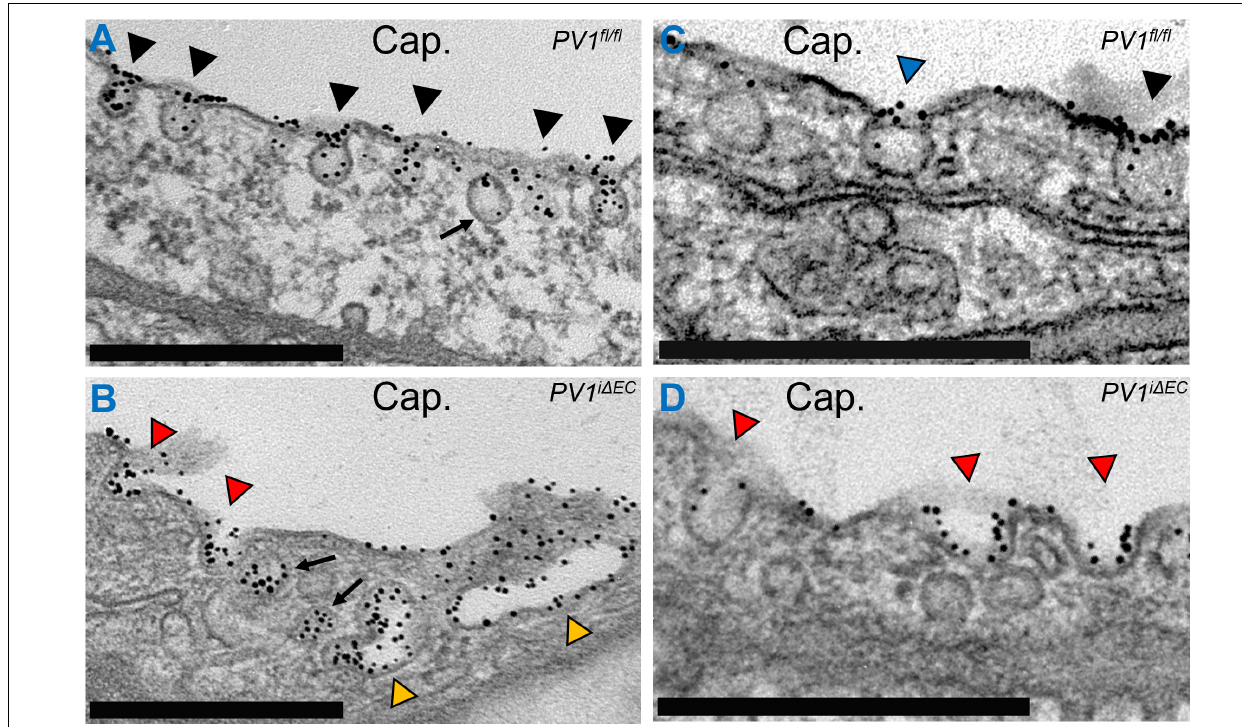
FIGURE 1 | Caveolar neck protein PV1 regulates vesicle shape and internalization. Gold-labeled (Au) albumin was infused into control ( PV1 fl / fl ) and PV1 deficient ( PV1 i (cid:49) EC ) mice for 15 min. Lungs were subsequently harvested, minced, fixed, and further prepared for electron microscopy. (A) Endothelial cells contain an abundant number of caveolar vesicles (black arrowheads). Most vesicles are present on the luminal and abluminal membranes. Here, caveolae are observed filled with Au-Albumin present in the capillary lumen (Cap.). An internalized vesicle is noted (arrow) inside the cell and will ultimately migrate to the abluminal surface to deposit its content. (B) Loss of PV1 in endothelial cells increases vesicle internalization, noted by fewer caveolae at the cell membrane and increased number of vesicles (arrows). Loss of PV1 also increases caveolae clusters (yellow arrowheads). (C) A survey of lung endothelial cells reveals caveolae that feature diaphragms (blue arrowhead) comprised of PV1 oligomers and caveolae without diaphragms (black arrowhead). (D) Loss of PV1 results in loss of diaphragms and change in caveolar shape (red arrowheads). Observable changes include increased vesicle neck width, increased vesicle depth, and increased vesicle filling. Scale bar, 0.5 µ m.